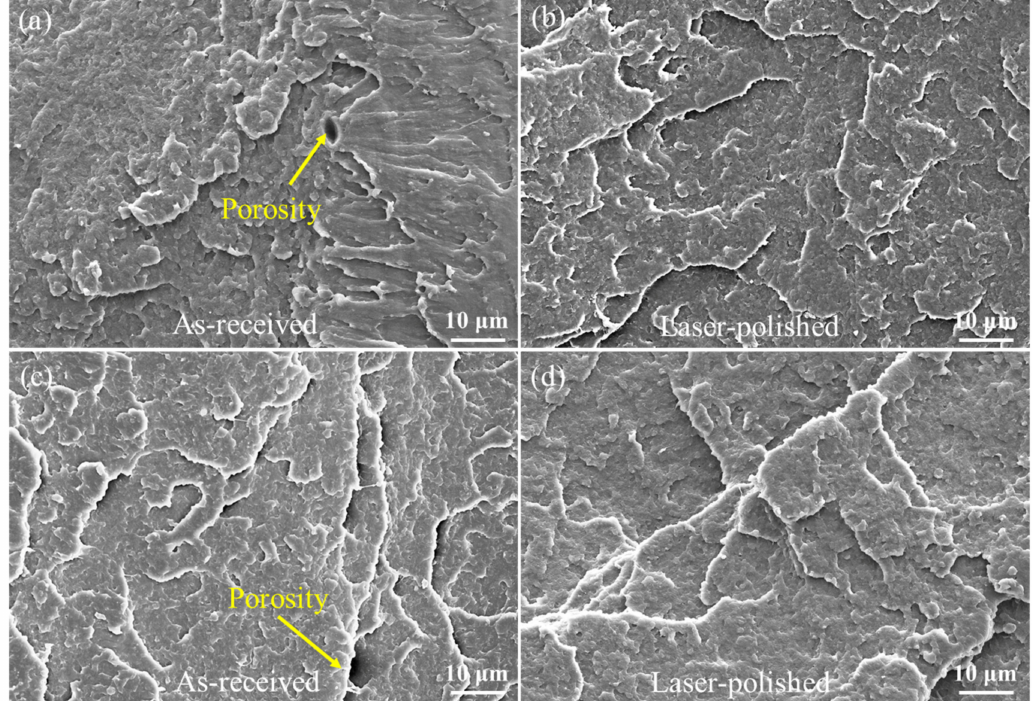
Figure 7. SEM fracture: ( a ) tensile SEM fracture of the as-received specimen; ( b ) tensile SEM fracture of the laser-polished specimen; ( c ) flexural SEM fracture of the as-received specimen; ( d ) flexural SEM fracture of the laser-polished specimen. The panels ( a – d ) in this figure correspond to Figure 5a–d,